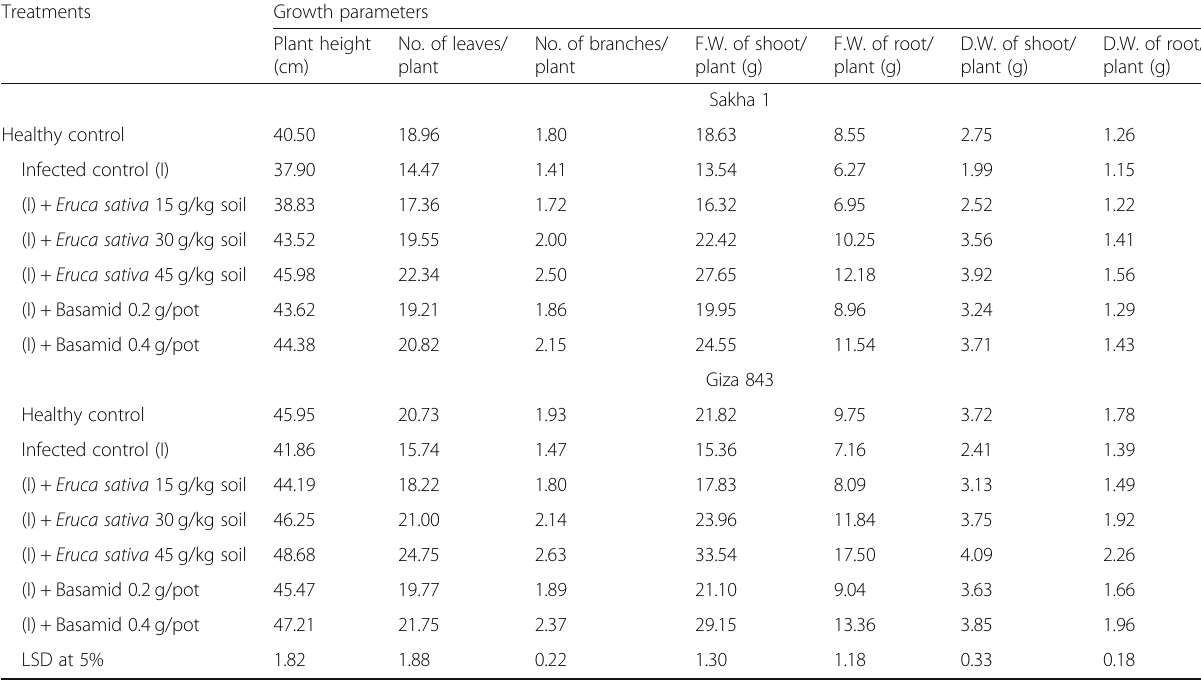
Table 2 Effect of different concentrations of Eruca sativa L. seed powder and Basamid herbicide on growth parameters of two Vicia faba L. cultivars at 60 days after sowing (combined analysis of two seasons) Treatments Growth parameters